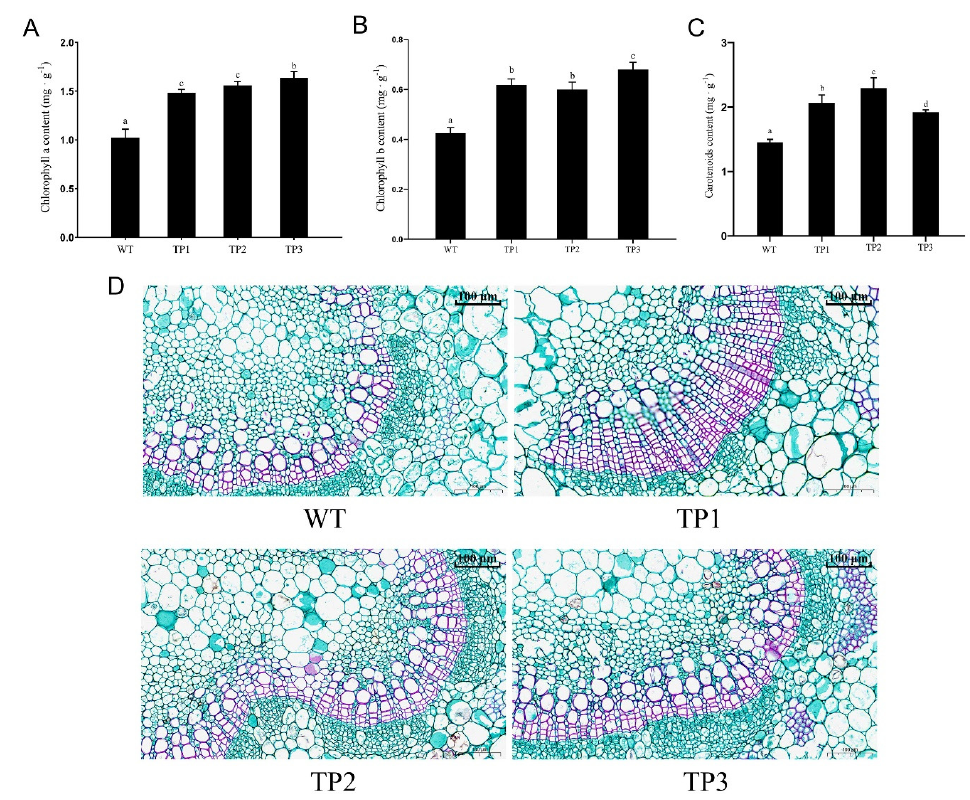
Figure 4. Effects of OsCYP85A1 on the photosynthetic pigment content and petiole morphological characteristics of transgenic plants. ( A ) Chlorophyll a. ( B ) Chlorophyll b. ( C ) Carotenoid. ( D ) Mor- phological characteristics of transverse section of petiole per unit area of transgenic plants. Error bars represent mean ± SD of three biological replicates. Different letters indicate a significant difference using the Tukey–Kramer test: p < 0.05.